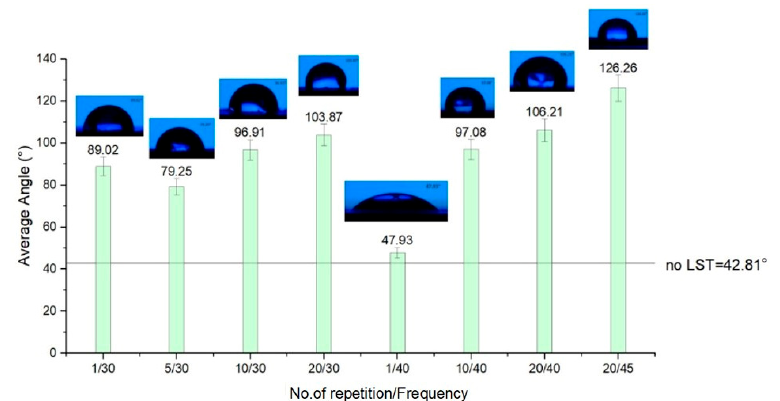
Figure 12. Average contact angle for design type B.